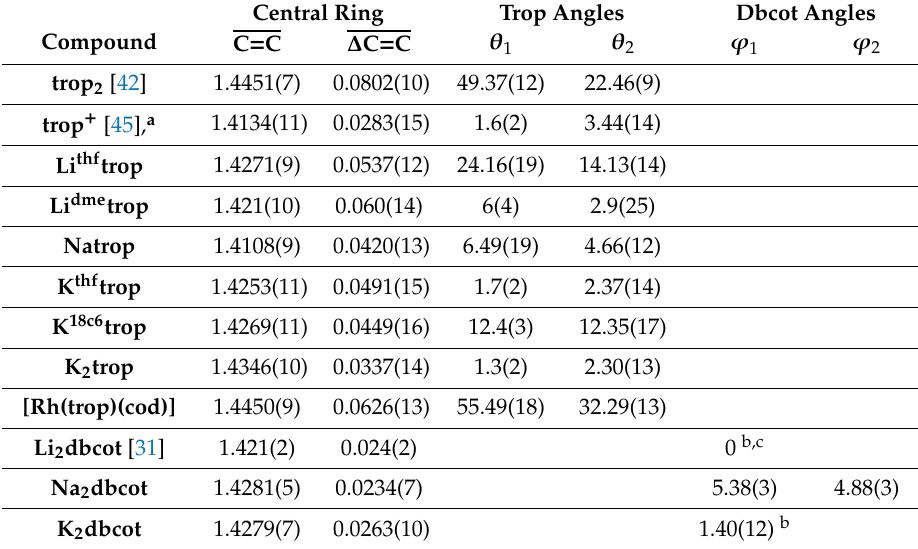
Table 4. Selected bond lengths (Å) for ion pairs containing the trop 2 ‒ and dbcot 2 ‒ dianions (Figure 2). Abbreviation: Cnt: centroid.